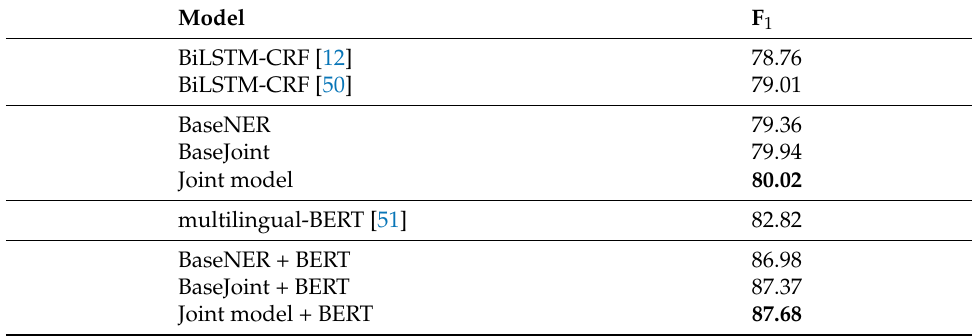
Table 5. F 1 -scores on CoNLL-2003 German.